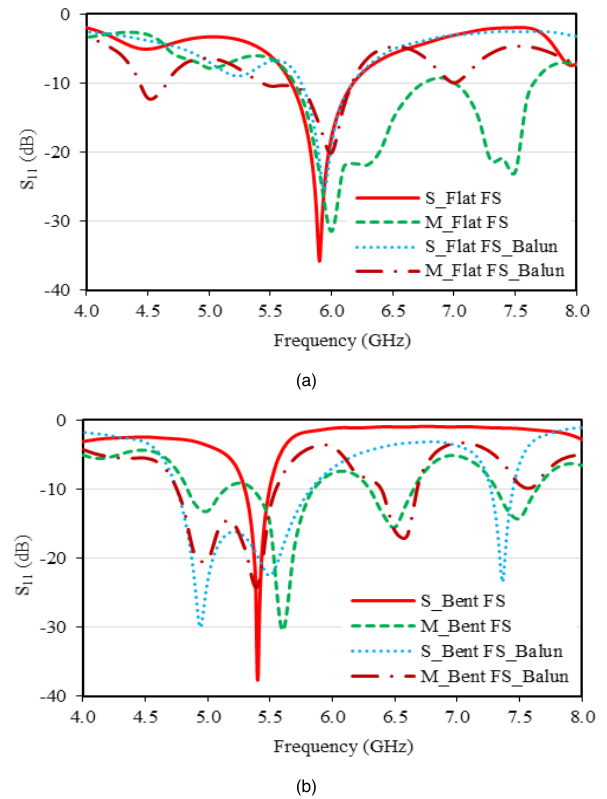
FIGURE 2. Reflection coefficients (S 11 ) of (a) flat and (b) bent flexible antenna in free-space (FS) based on simulation (S) and measurement (M)